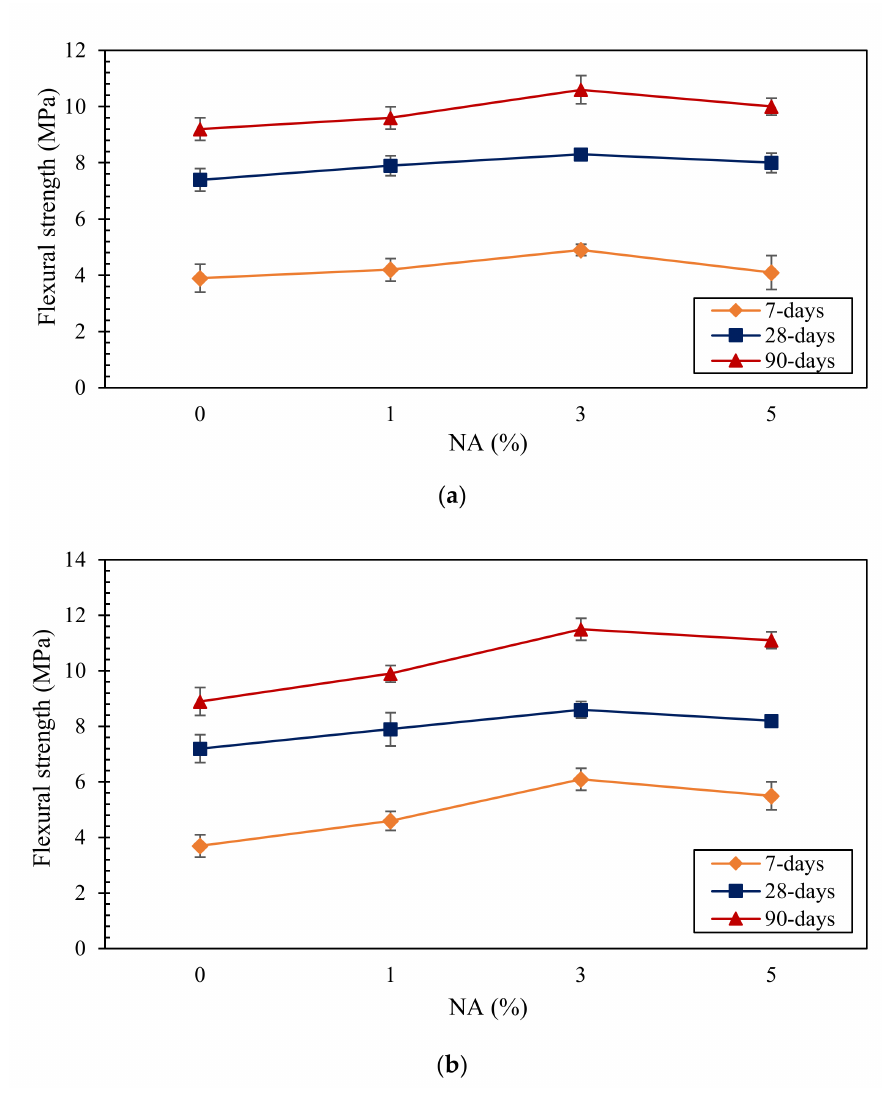
Figure 2. Flexural strength of SC mortars, ( a ) RHA = 0%, ( b ) RHA = 30%.